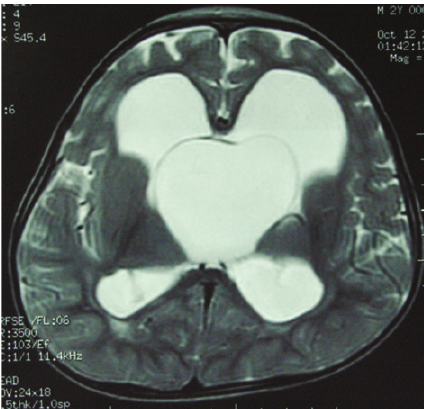
Figure 3: The postoperative MRI image of the patient showed total resection of the cyst lesion, but there existed symmetrical lesions at basal ganglia area (T2 weighted